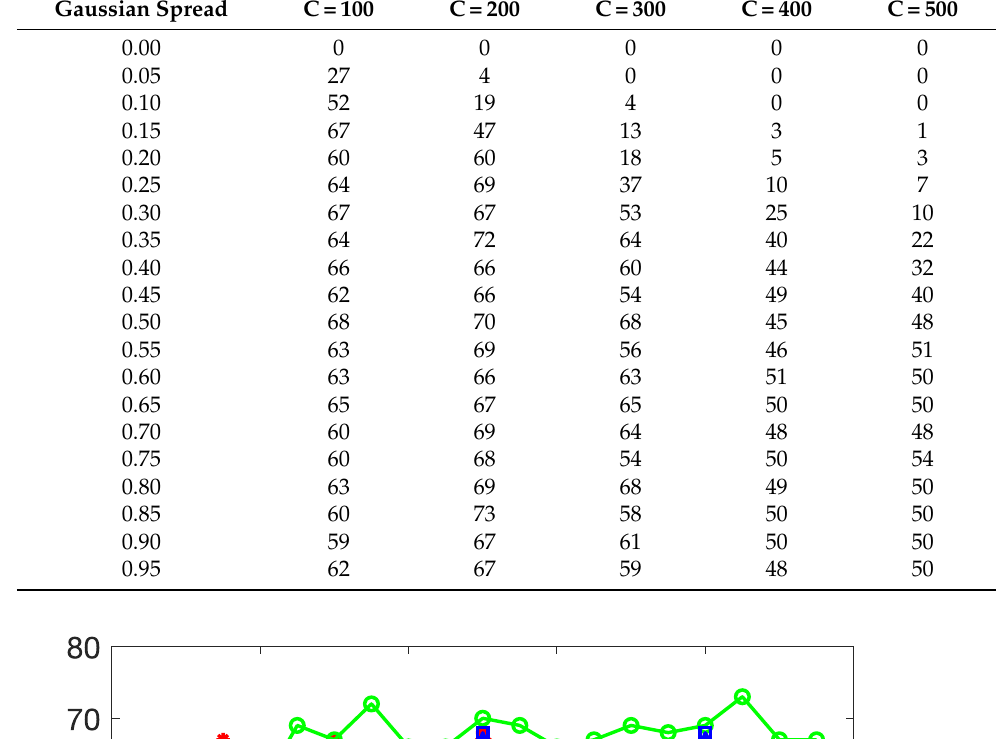
Table 2. Performance results for increasing PNN column length and Gaussian spread parameter.